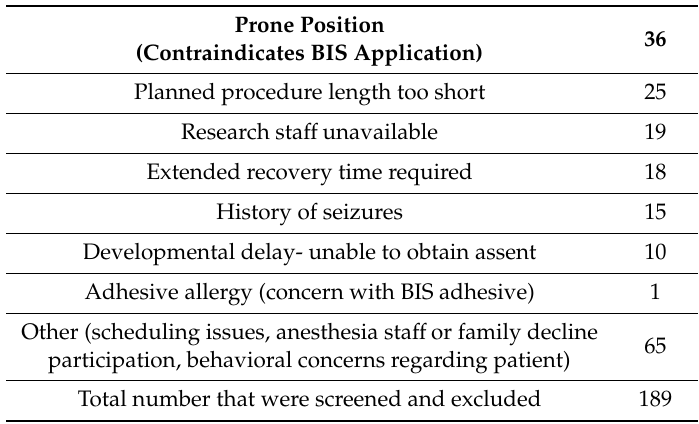
Table 1. Detailed reasons (number of patients) for meeting exclusion criteria.